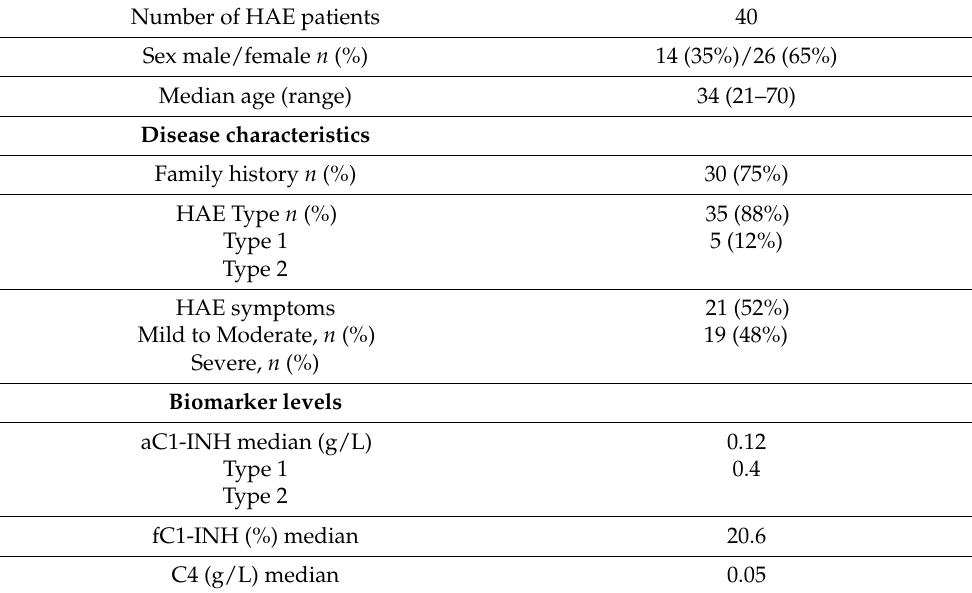
Table 4. HAE Patients’